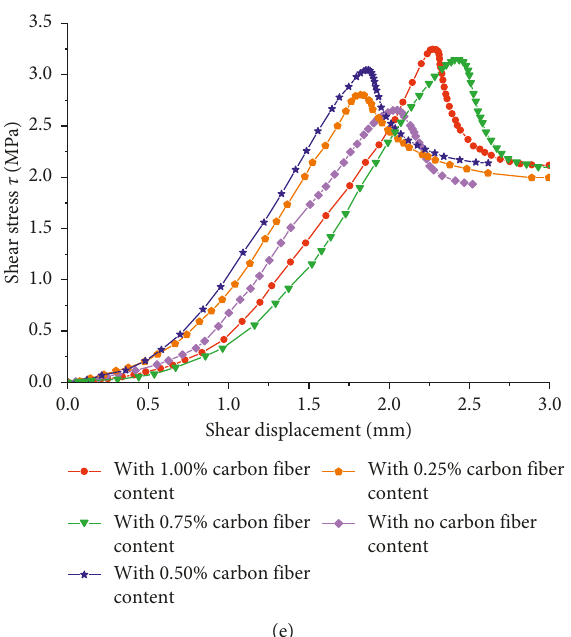
Figure 6: Shear stress-displacement characteristics at different normal stress levels: (a) 0.5MPa; (b) 1.0MPa; (c) 1.5MPa; (d) 2.0MPa; (e)